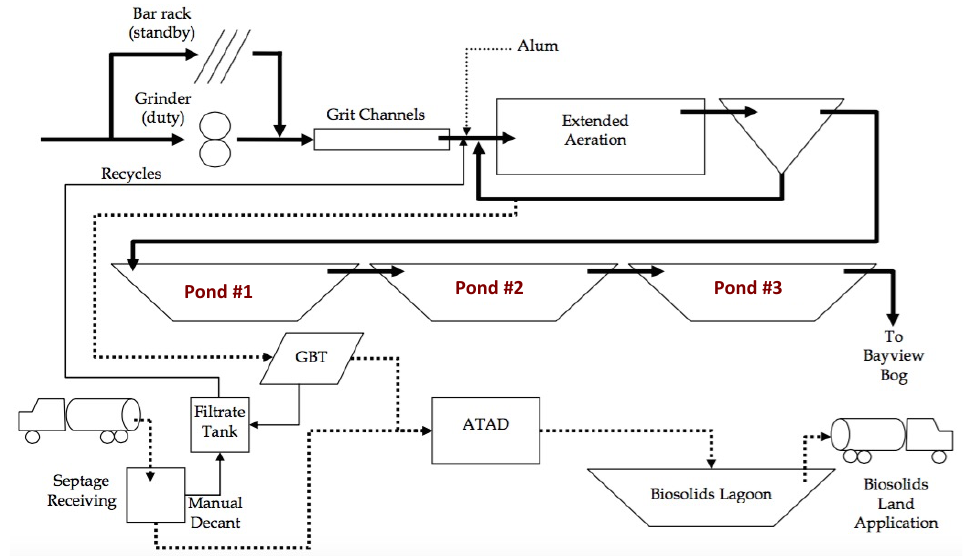
Figure 1. The configuration of the wastewater treatment plant [18].